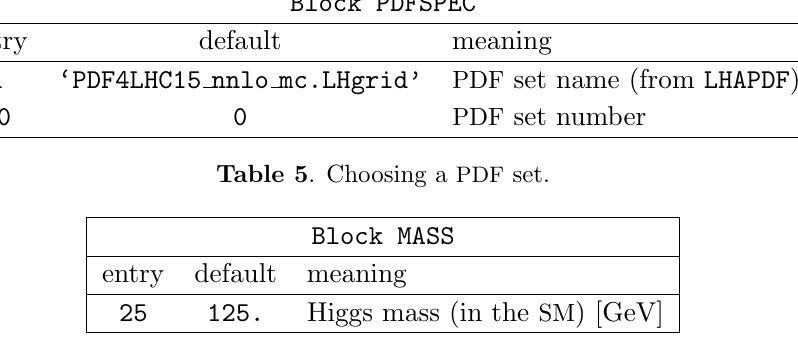
Table 6 . Setting the Higgs mass in the SM . For the 2HDM and the MSSM , see table